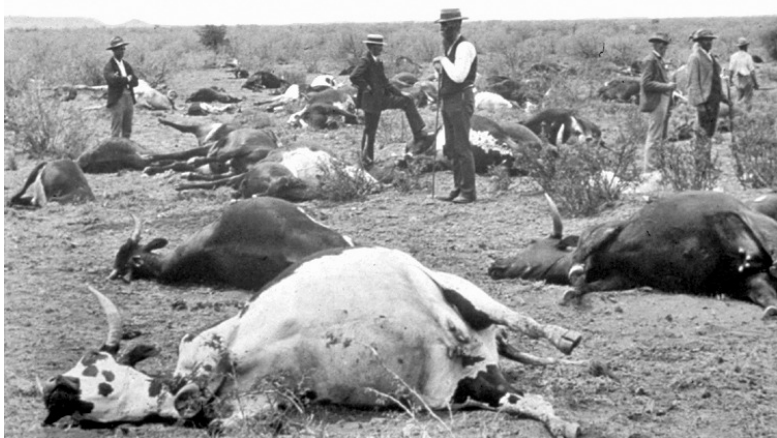
Figure 20. Rinderpest epidemic in South Africa, 1897 (Onderstepoort Collection)